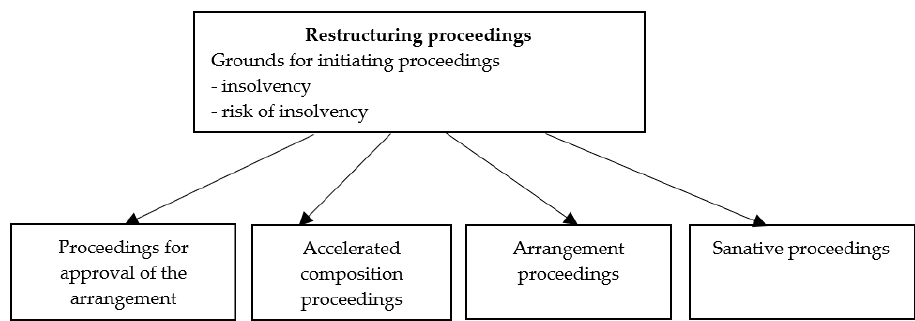
Figure 1. Types of proceedings in Polish restructuring law. Source: Own elaboration.